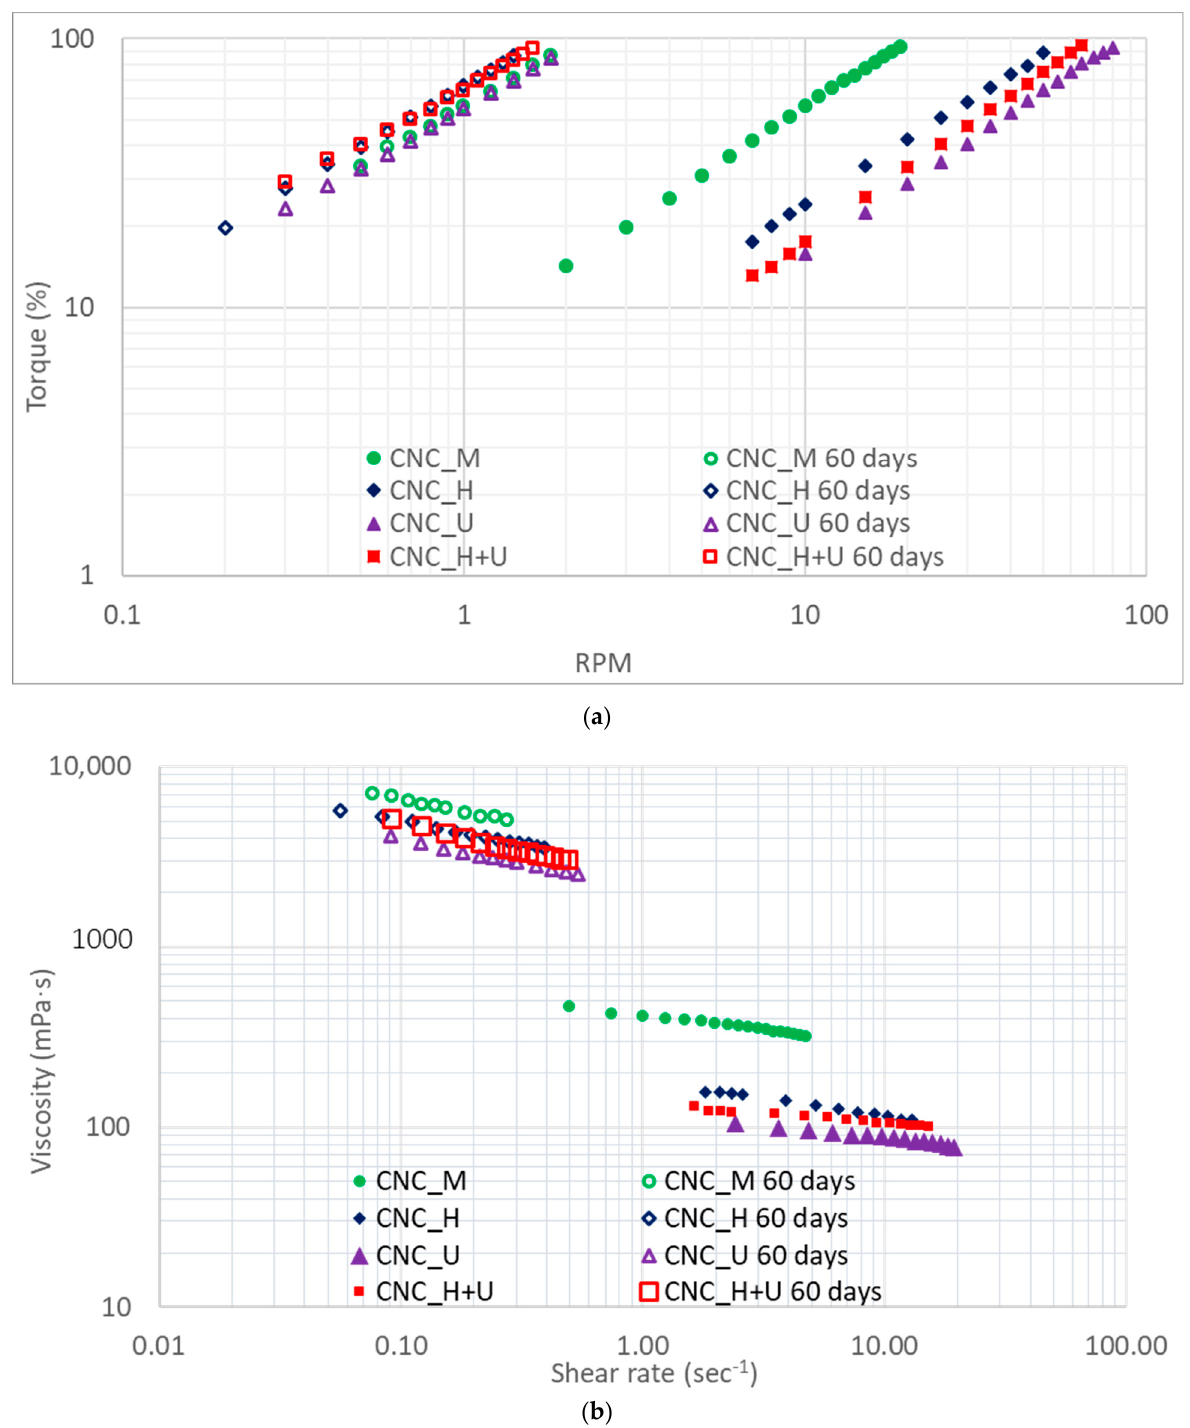
Figure 4. The viscosity of the CNC suspension after settling for sixty days ( a ) torque versus RPM and ( b ) viscosity versus shear rate.